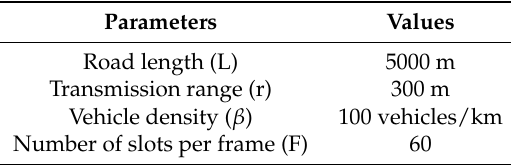
Table 1. Basic simulation